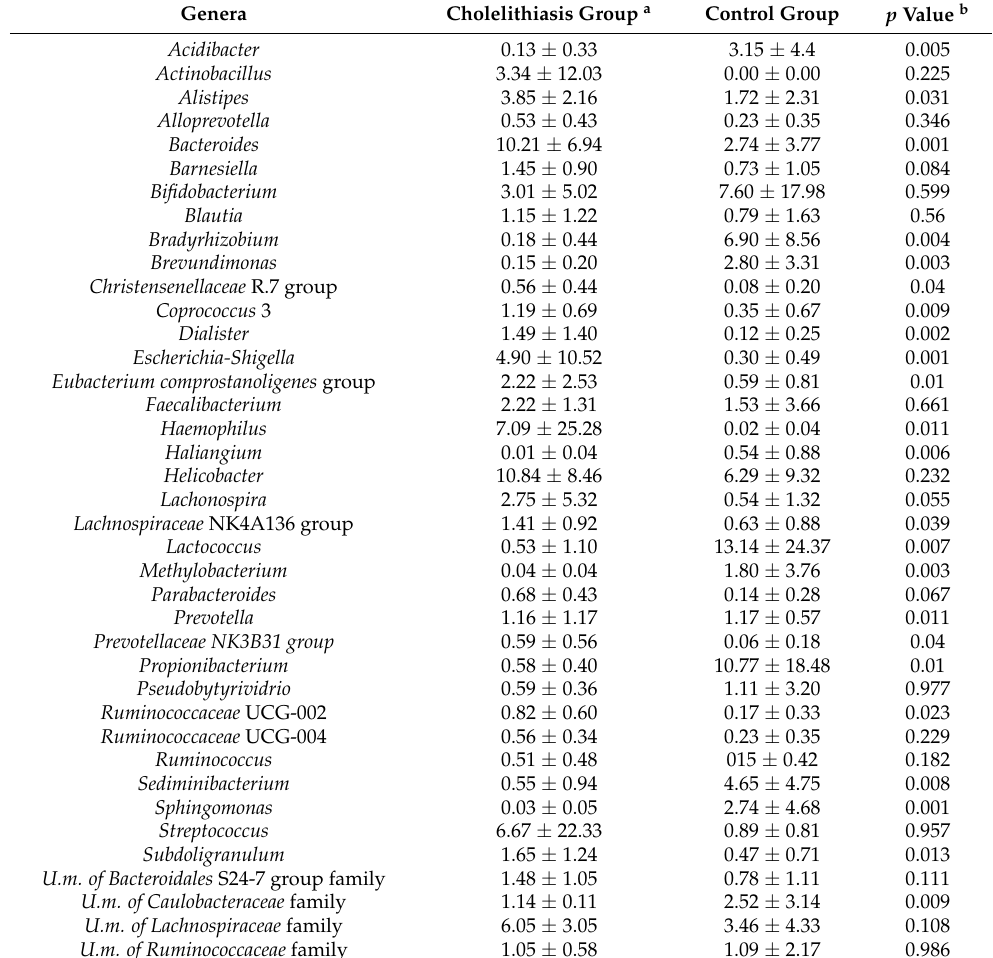
Table 1. Differences in microbial relative abundance (% of sequences) in bile at genus level between cholelithiasis patients and the control group. Only genera with a mean relative abundance higher than 0.5% are presented. Only genera that were detected in more than half of the samples in each group were considered for the analysis. Directly taken from Molinero and colleagues in 2019 [24] with permission from the editorial office and